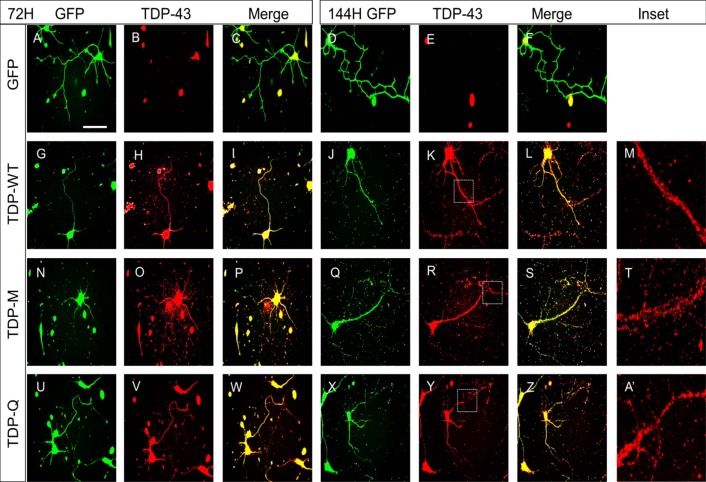
TDP-43 mislocalisation visualised with anti-TDP-43 antibodies.Rat cortical neurons were transfected with GFP control, and GFP-tagged TDP-43 wild-type and mutant isoforms as labelled and analysed at 72 H and 144 H. Immunostaining with anti-GFP (green) and anti-TDP-43 antibodies (red). Scale bar– 10 µm. Insets—higher power views of corresponding panels to the left, stained with anti-TDP-43 antibodies. Scale bar = 10 µm.